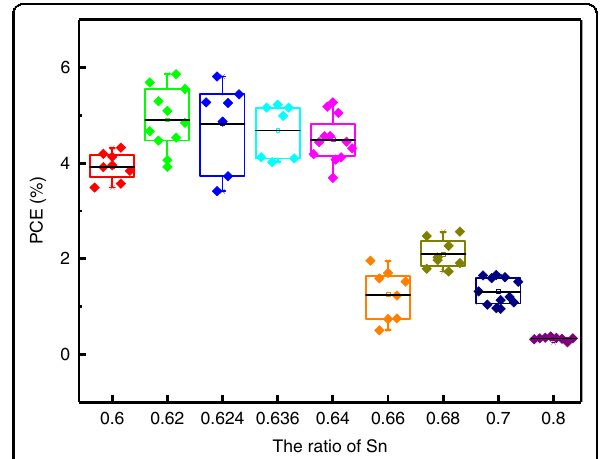
Fig. 5 The experimental PCE of MASn x Pb 1-x I 3 perovskite solar cells with different Sn